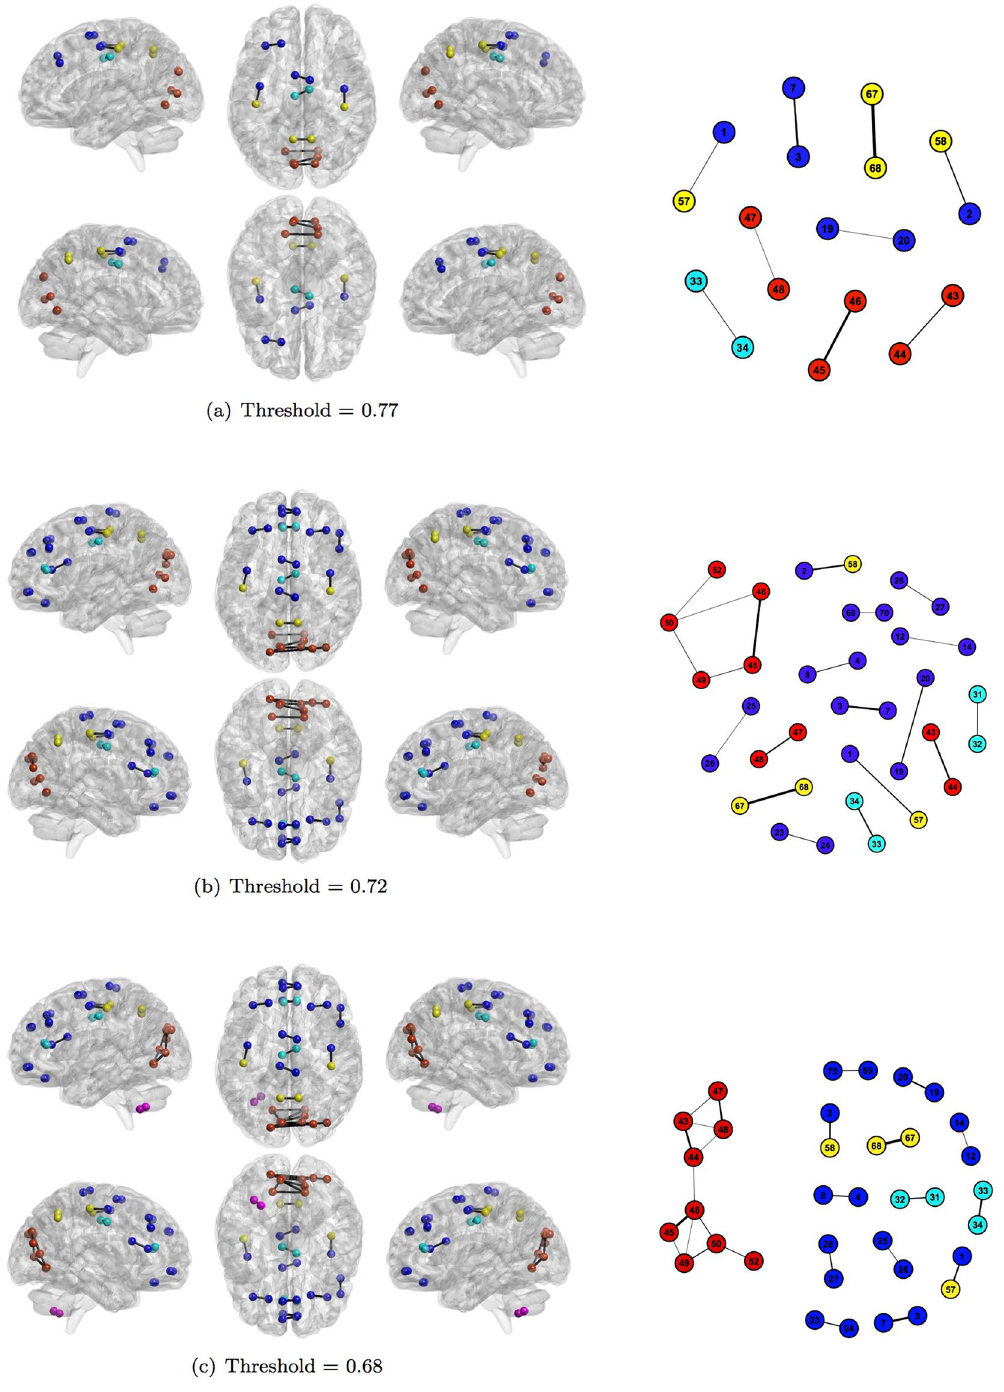
Figure 5. Snapshots of the human functional brain network. Each snapshot is realized thresholding the correlation matrix. Thresholds are chosen looking at the most significant deviation of plateaux length of the real percolation curve from its ensemble of randomization (Fig. 2(b)) Colors represent anatomical regions according to the grouping of AAL parcellation in Fig. 3(a): Frontal Lobe; Insula; Cingulate; Temporal Lobe; Occipital Lobe; Parietal Lobe; Deep Grey Matter; Cerebellum. Link thickness represents the strength of